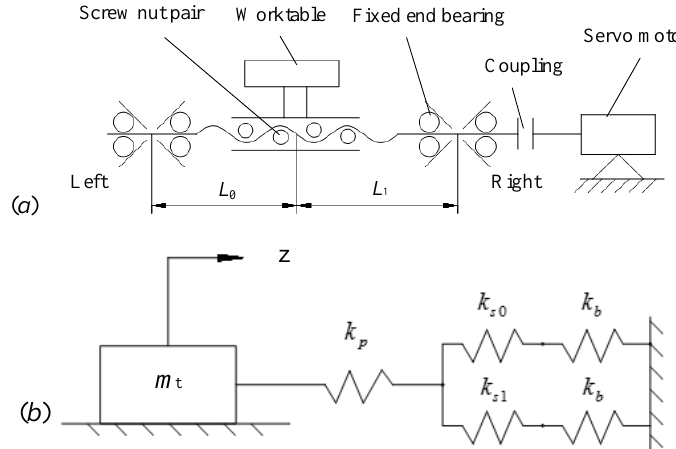
Figure 26. Acceleration signal and torque current of servo motor (TCSM) signal. ( a ) Acceleration signal. ( b ) TCSM signal.